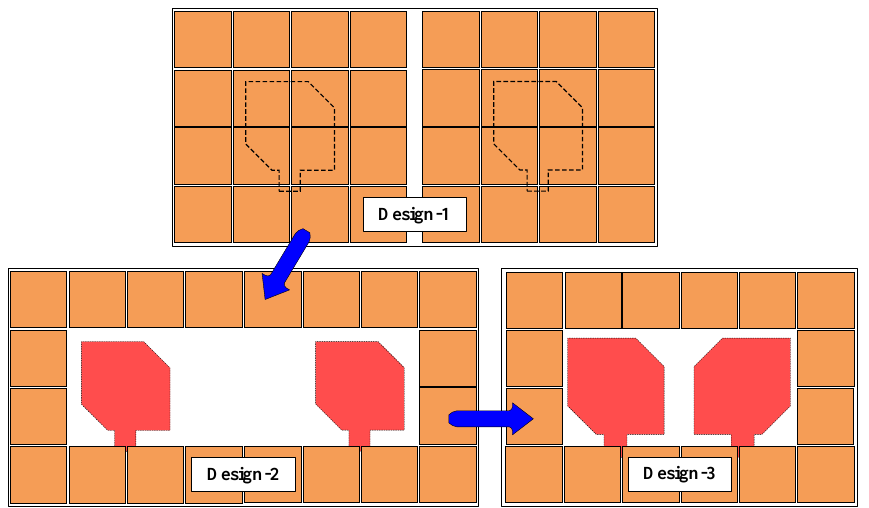
Figure 4. Different configurations of MIMO CP antennas with MS.